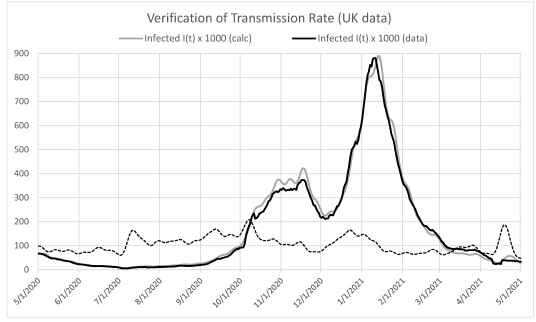
Figure 3. The observed and simulated dynamics of the new infected number in COVID-19 epidemic in the UK. The reproduction number (dotted curve) is found from the identification problem (3.1).